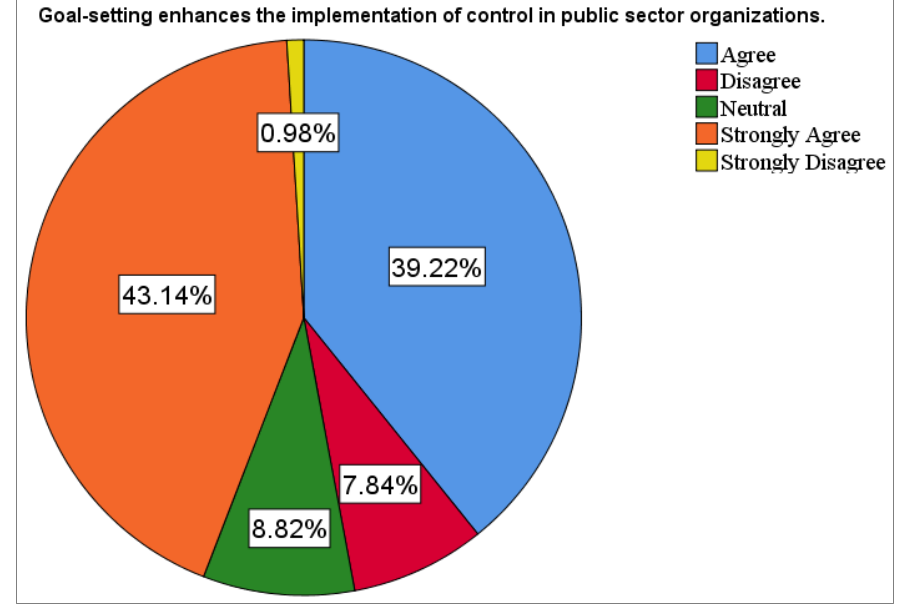
Figure 6. Goal setting enhances the implementation of control in public sector organizations